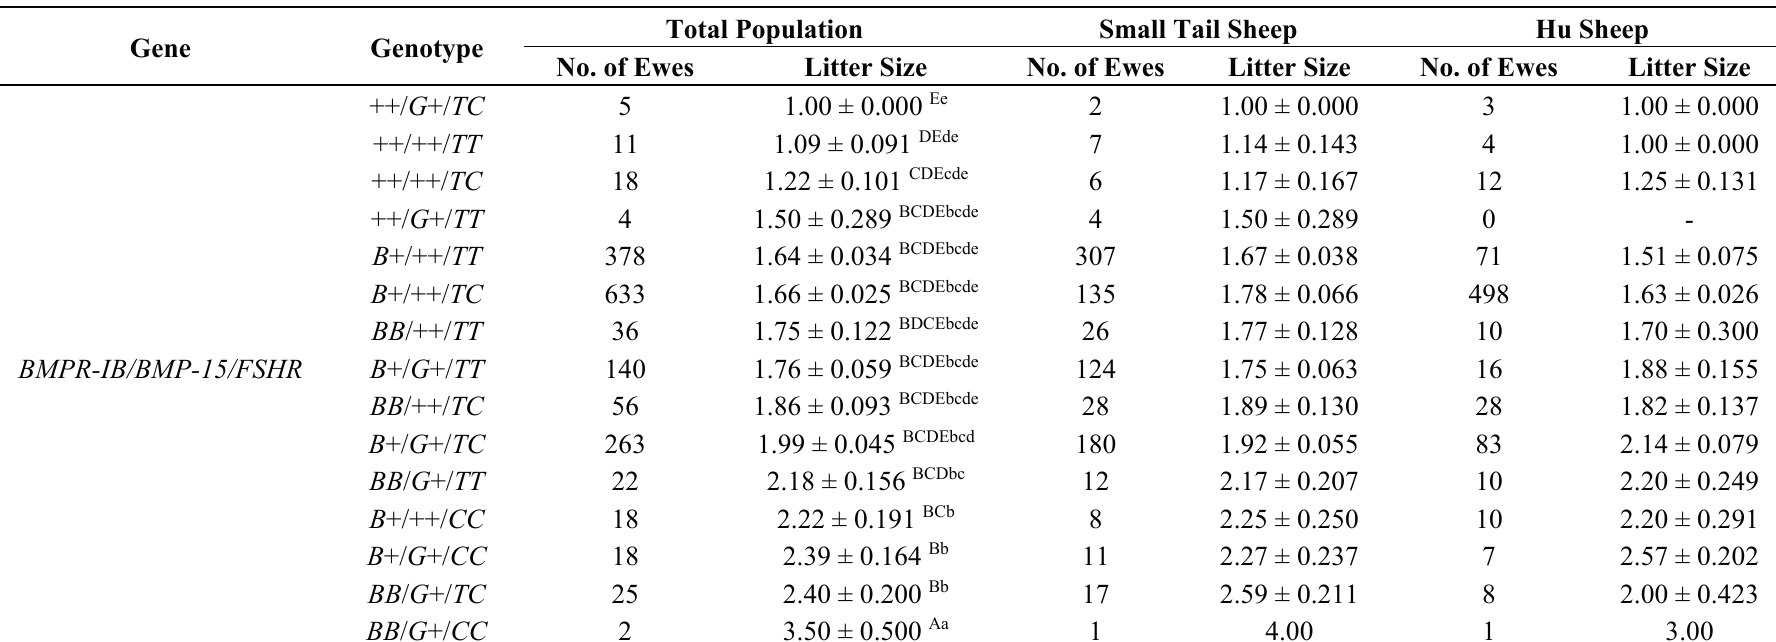
Table 4. Combined effect analysis of BMPR-IB , BMP-15 and FSHR genes on litter size. Gene